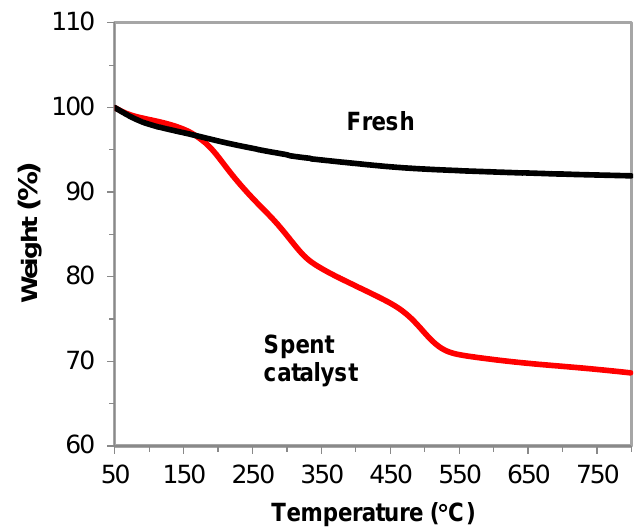
Figure 11. Thermogravimetric analysis of fresh and spent catalyst of 5Cu-1B/Al 2 O 3 after 70 h on stream.